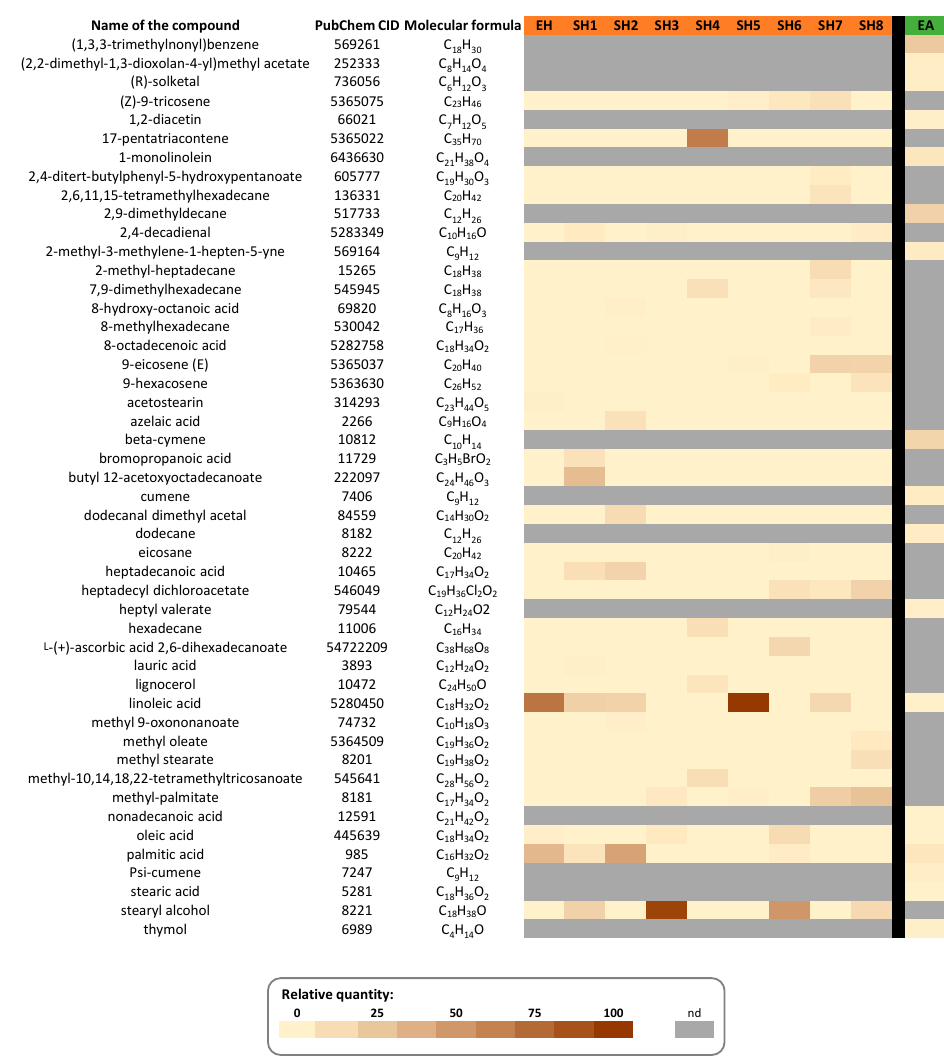
Figure 2. Relative abundance (in % of TIC (total ion chromatogram)) of the main components of N. sativa seeds hexane (EH) and acetone (EA) extracts and resulting hexane fractions (SH1-SH8) determined by GC–MS analysis. GC–MS chromatograms are shown in Figure S1. Values are given in Table S1. nd: not detected.